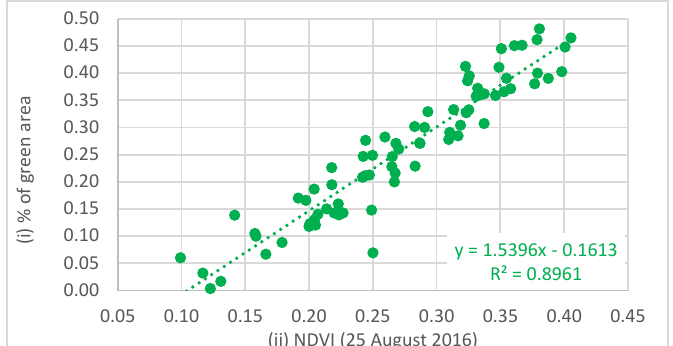
Figure 12. Analysis of the vegetation in the Politecnico area at a district scale: comparison between the two methodologies. ( a ) Green area extraction with the FA tool (i); ( b ) Percentage of green areas obtained using the FA results; ( c ) NDVI values obtained using Landsat 8 images (ii) on 25 August 2016.